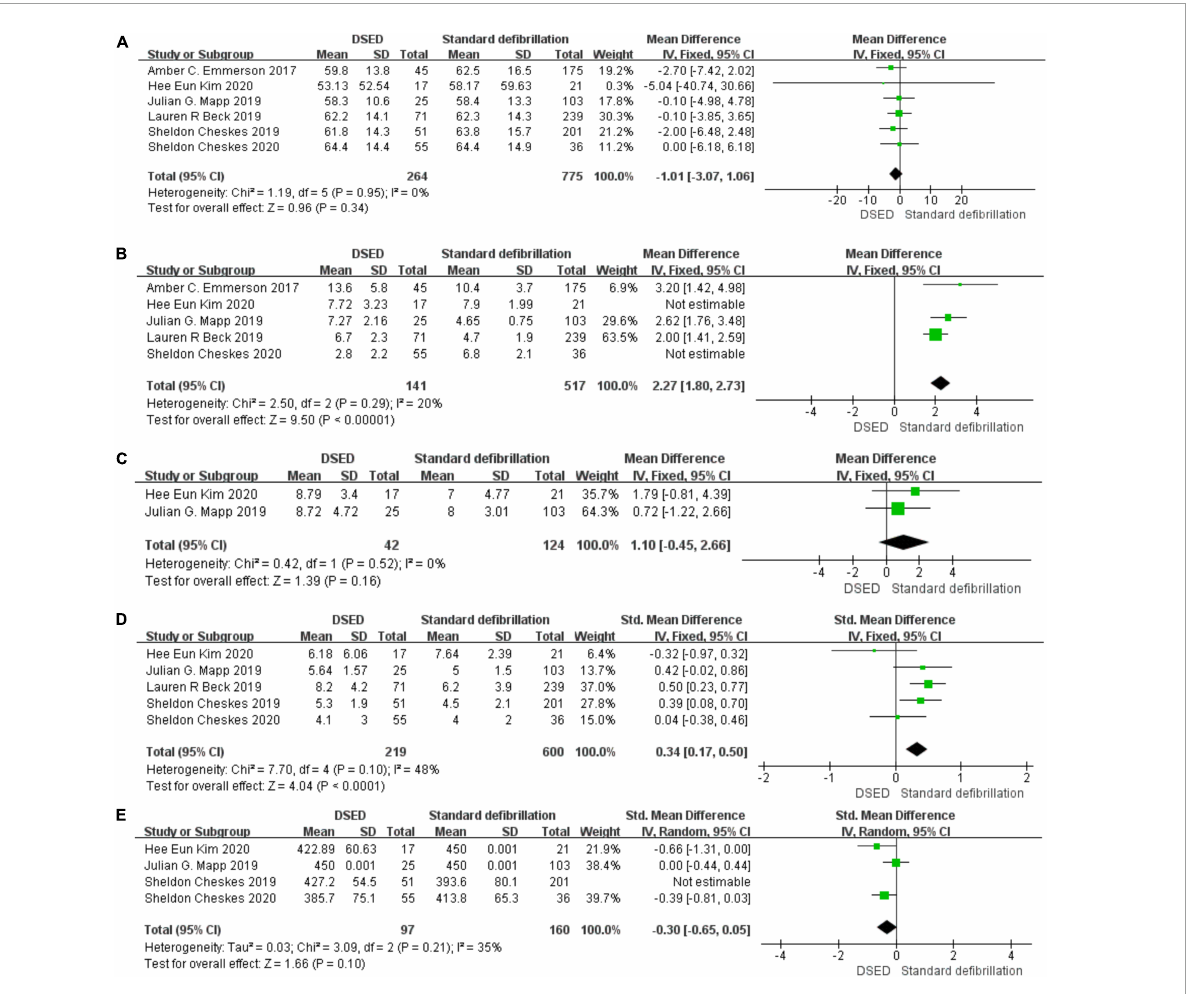
FIGURE4 Age: Forest plot (A) . Total defibrillation attempts: Forest plot (B) . Emergency Medical System arrival time: Forest plot (C) . Epinephrine: Forest plot (D) . Amiodarone: Forest plot (E)